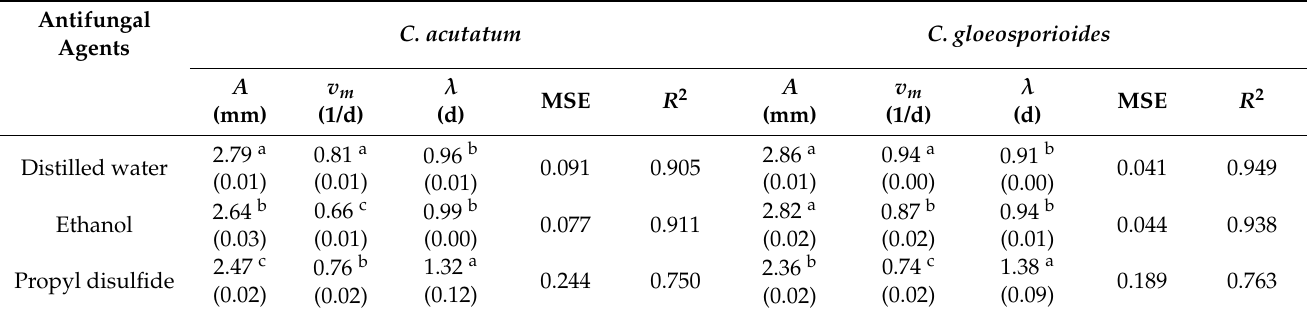
Table 3. Modified Gompertz model parameters for vapor diffusion assay.